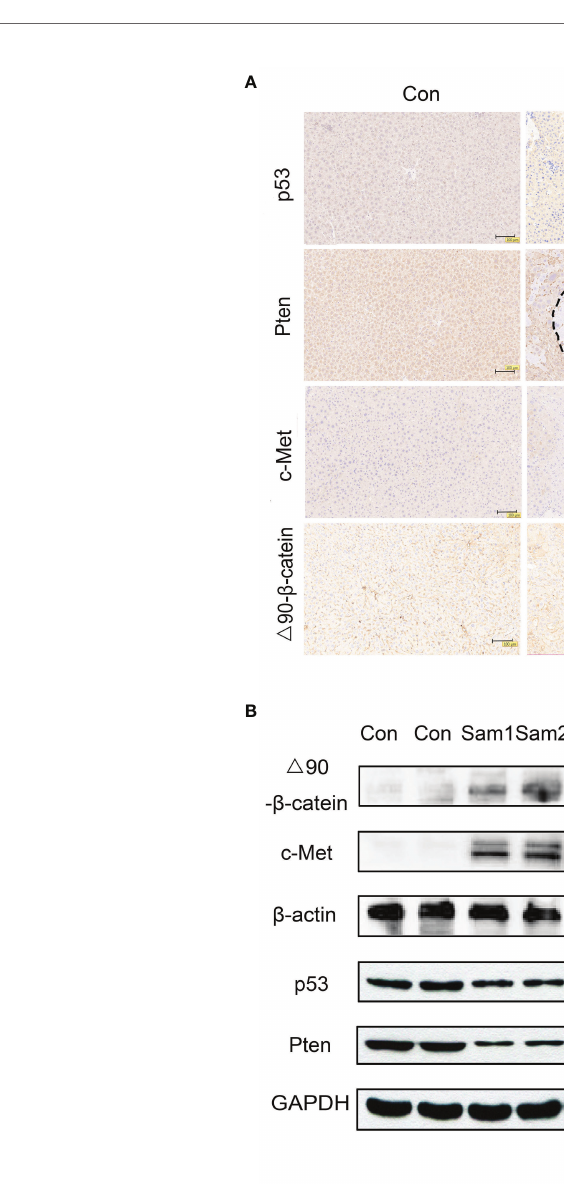
FIGURE 3 | Gene alterations in the liver tumor nodules. (A) Immunohistochemical (IHC) of liver tumor tissues indicating knockout of Pten and p53 and overexpressions of c-Met and △ 90- b -catenin. (C-carcinoma, L-liver) (Magni fi cation: 100x) Mean ± S.D; n=3, Statistical signi fi cance determined with t test; *P<0.05, **P<0.01, ****P<0.0001. (B) Immunoblot showing overexpressions of c-Met and △ 90- b -catenin protein and decreased levels of p53 and Pten proteins in the mouse liver. *P<0.05, ** P<0.01,